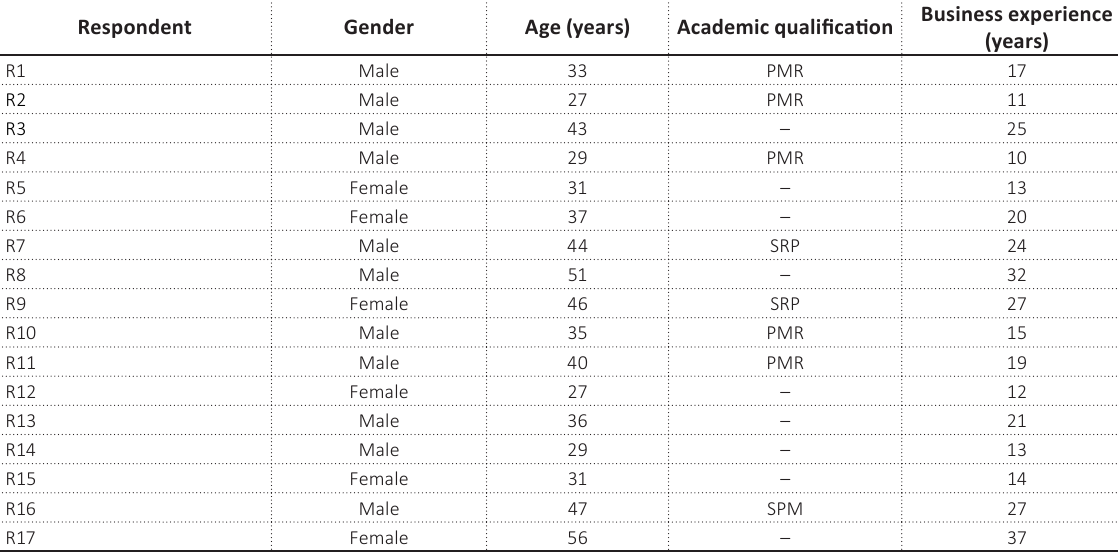
Table 1. The list of respondents’ profile among citizens Respondent